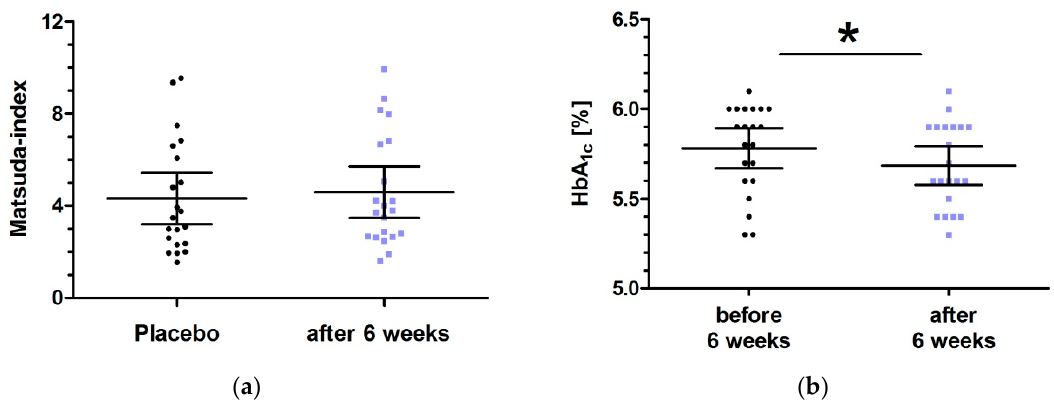
Figure 4. Insulin responses to low and high dose milk protein hydrolysate containing bioactive peptides consumed 15 min prior to a challenge meal. Data represent mean ±95% CI. 3.4. Six Week Intervention with Low Dose Milk Peptides Plasma concentrations of fasting blood glucose and fasting insulin after six weeks of low dose milk peptides intervention were comparable with the fasting conditions prior to the challenge meal with single dose placebo intervention [baseline vs. six week intervention: 108.0 mg/dL (95% CI: 103.6–112.4) vs. 106.8 mg/dL (95% CI: 102.4–111.1) for glucose ( p = 0.5165); 11.01 mg/dL (95% CI: 8.68–13.34) vs. 10.67 µU/mL (95% CI: 8.22–13.12) for insulin ( p = 0.3352)]. Approximation of whole-body insulin sensitivity, which combines both hepatic and peripheral tissue insulin sensitivity, was performed by assessment of the Matsuda index; 61.9% of subjects were in the pathological range with values <4, 9.5% in the borderline range with values between 4 and 6, and 28.6% were in the normal (healthy) range with values of 6–12 at baseline, defined as the condition